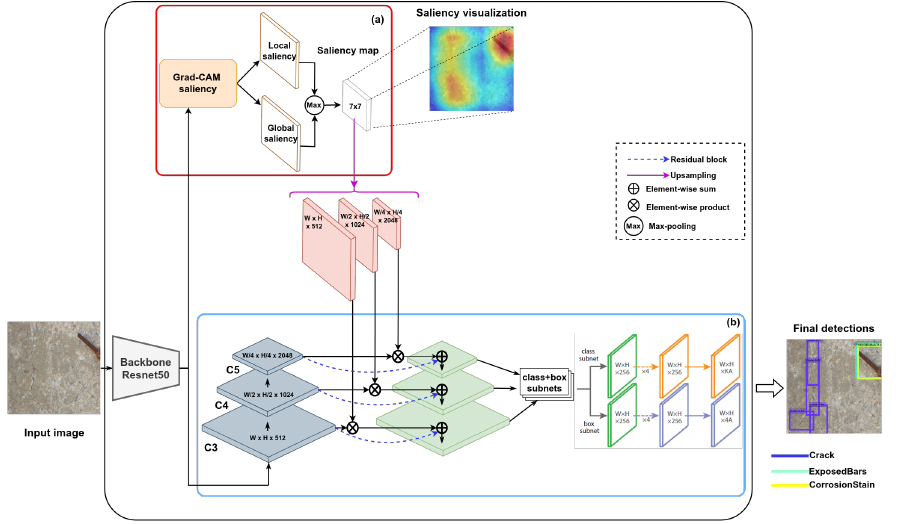
Figure 2. Pipeline of the proposed SMDD-Net method: ( a ) attention module enhancing regional feature representation for defect detection; ( b ) the multi-label one-stage defect detection module uses the RetinaNet